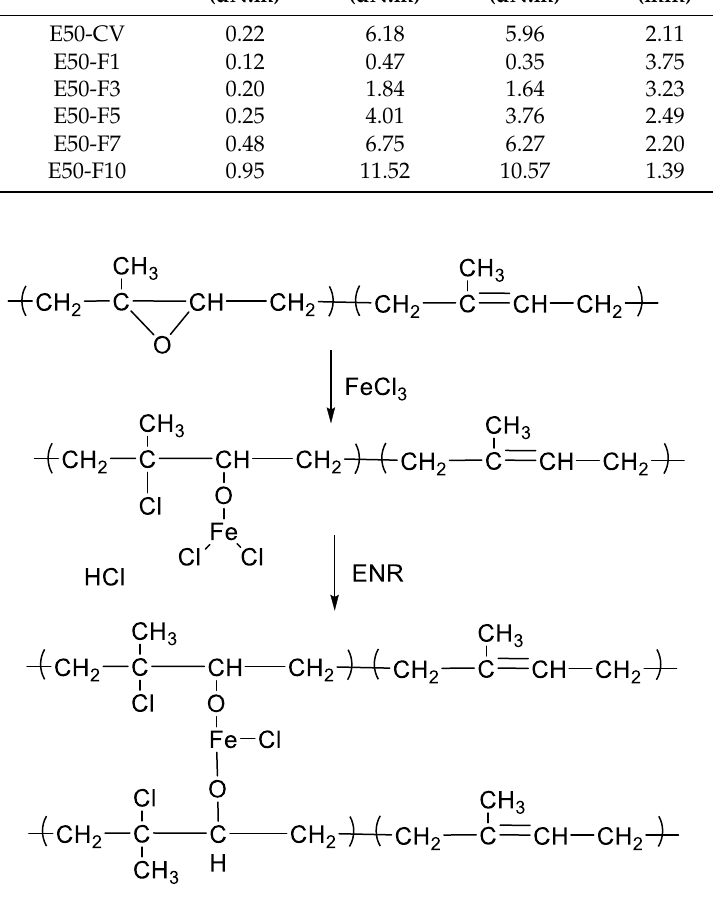
Figure 3. A proposed reaction mechanism between epoxidized natural rubber and ferric chloride. The nucleophilic chloride is attached with β position with respect to the methyl group.